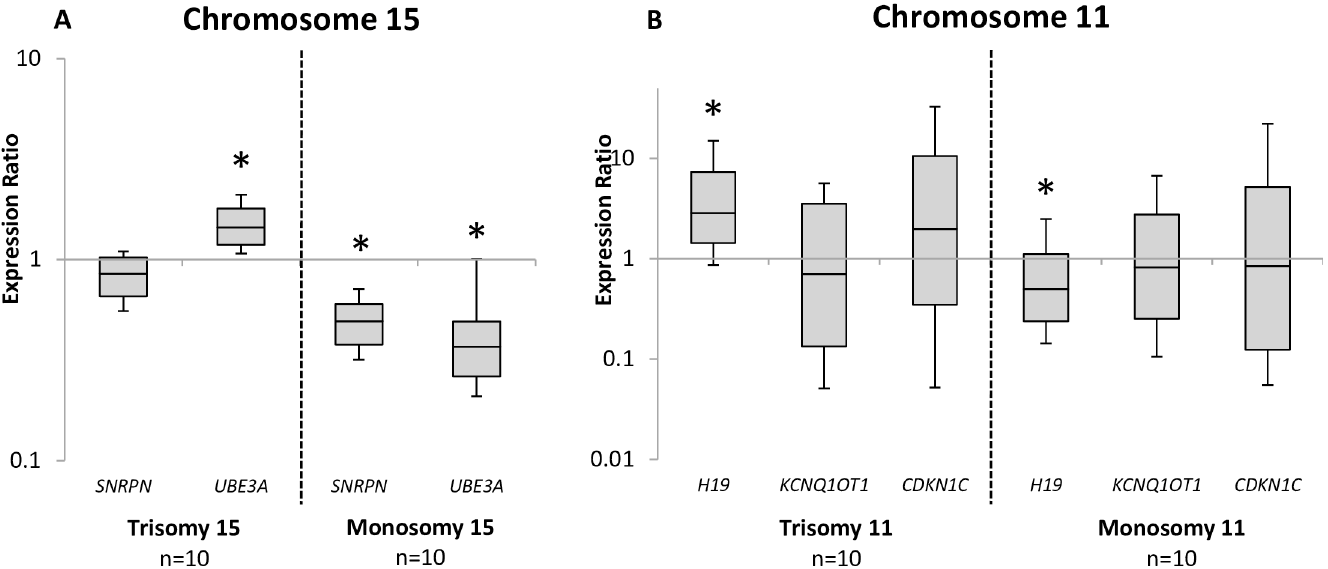
Fig 4. Summary of relative expression for imprinted genes on Chromosome 15 and Chromosome 11 in individual blastocysts. A) Relative gene expression of SNRPN and UBE3A in control blastocysts (n = 10) compared to trisomy 15 (n = 10) and monosomy 15 (n = 10) blastocysts. B) Relative gene expression of H19 , KCNQ1OT1 and CDKN1C in control blastocysts (n = 10) compared to trisomy 11 (n = 10) and monosomy 11 (n = 10) blastocysts. Relative expression between control and aneuploid groups was normalized to the housekeeping gene PPIA (7p13) using the Relative Expression Software Tool (REST) to determine an expression ratio that was tested for significance by a Pair Wise Fixed Reallocation Randomization Test. Differences were considered to be statistically significant when p < 0.05, Star “ * ” denotes statistical